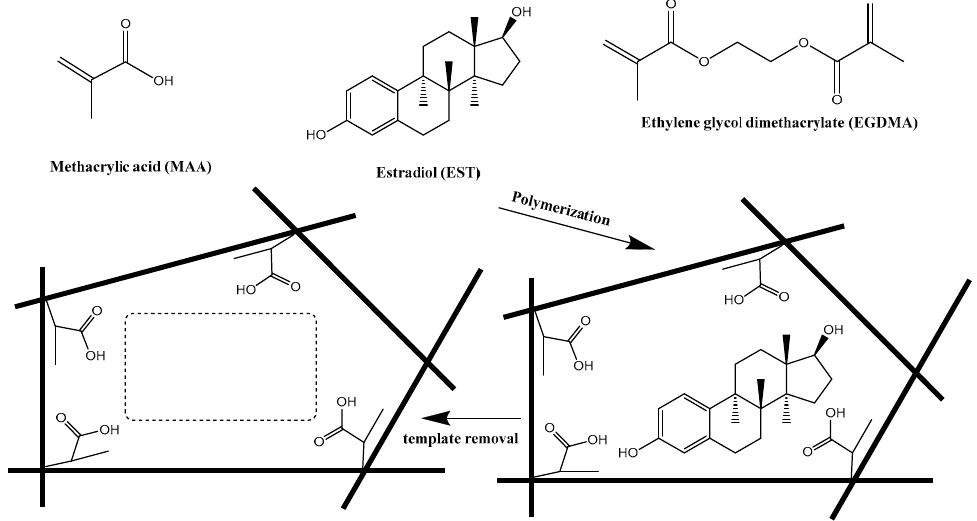
Figure 1. Protocol of synthesis of molecularly imprinted polymers (MIPs) and its recognition towards 17 β -estradiol.